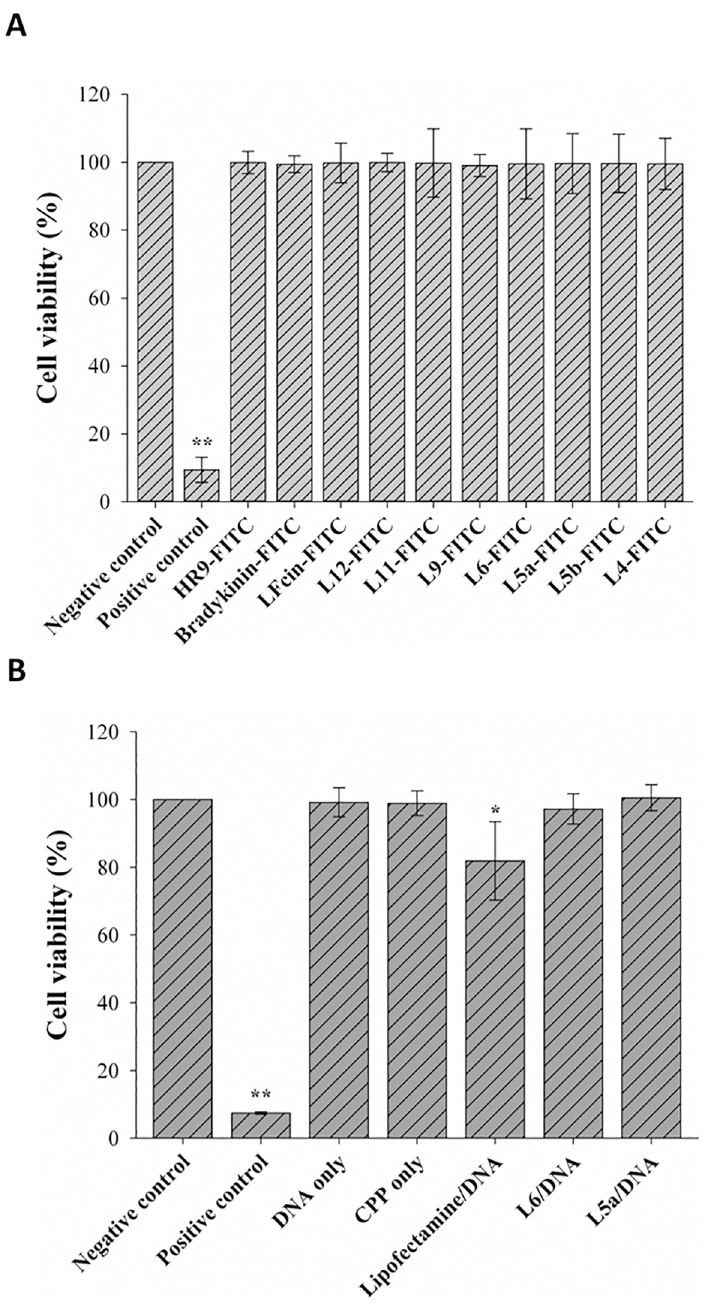
Fig 8. Cytotoxicity of CPPs, DNA, and CPP/DNA complexes. (A) Cytotoxicity of CPPs. Cells were treated with 10 μ M HR9-FITC, bradykinin-FITC, or eight FITC-labeled LFcin derivatives at 37°C for 24 h. Cells treated with serum-free medium and 100% DMSO at 37°C for 24 h served as negative and positive controls, respectively. The MTT assay was used to evaluate cytotoxicity. Significant differences from the negative control at P < 0.01 ( ** ) are indicated. Data are presented as mean ± SD from five independent experiments in each treatment group. (B) Cytotoxicity of DNA and CPP/DNA complexes. Cells were treated with 1.6 μ g DNA, 10 μ M CPPs, Lipofectamine 2000/DNA, or CPP/DNA complexes prepared at an N/P ratio of 12 at 37°C for 24 h. Significant differences from the negative control at P < 0.01 ( ** ) are indicated. Data are presented as mean ± SD from five independent experiments in each treatment